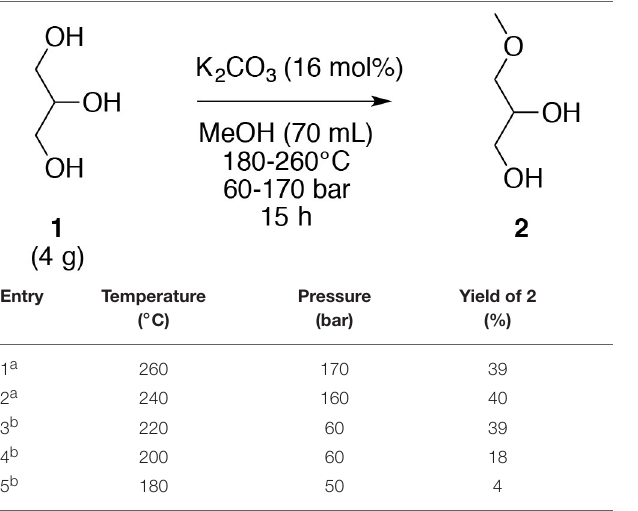
TABLE 1 | O -Methylation of glycerol ( 1 ) in sub- and supercritical methanol under varying temperatures.